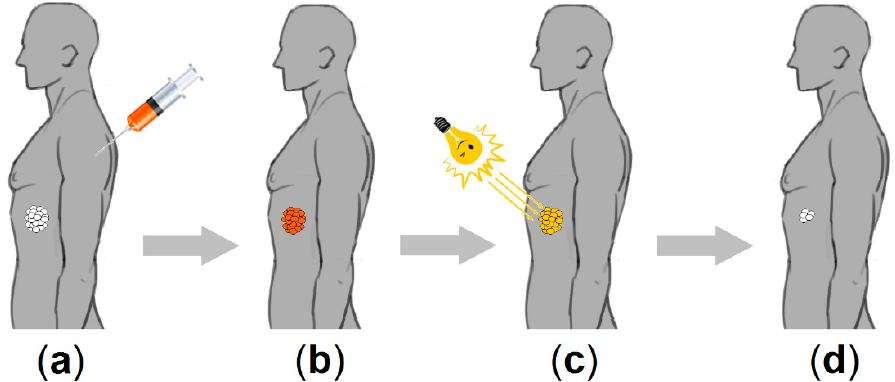
Figure 1. Two-step photodynamic therapy (PDT) cancer treatment process involving: ( a ) photosensitizer (PS) injection; ( b ) PS accumulation in the tumor; ( c ) PS activation by light; ( d ) reactive oxygen species (ROS) production and tumor damage response.